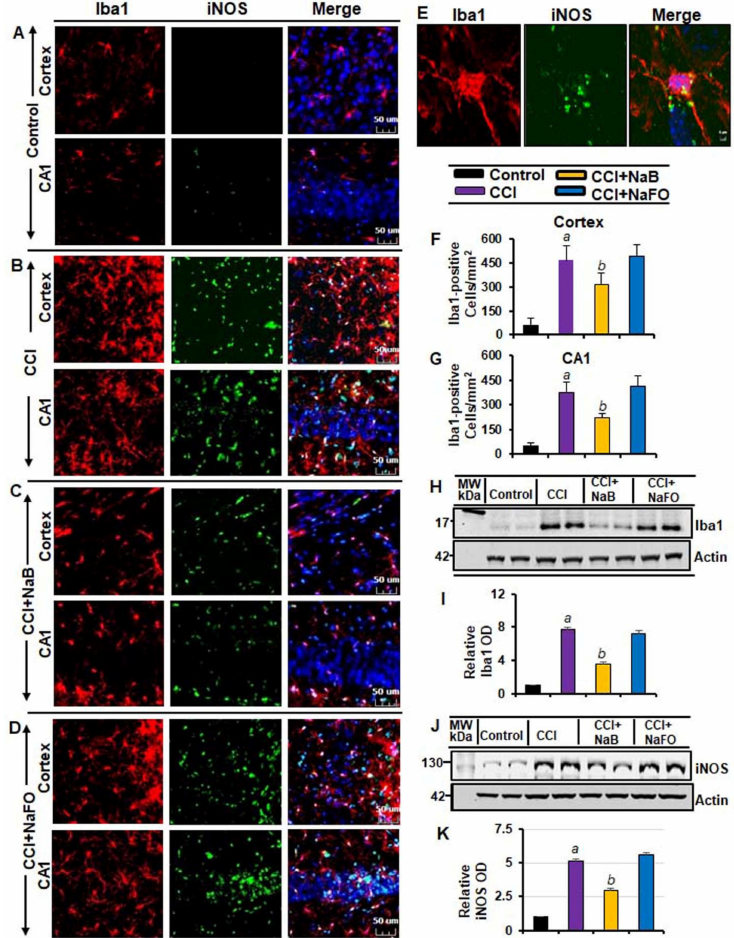
Figure 3. NaB treatment inhibits microglial activation in vivo in the cortex and hippocampus of mice with CCI injury. Mice were treated with 50 mg/kg/day of NaB or NaFO from 24 h after the induction of CCI injury. After 7 d of treatment, brain sections were analyzed by double-label fluorescence for Iba1 and iNOS (( A ), control; ( B ), CCI; ( C ), CCI+NaB; ( D ), CCI+NaFO). ( E ) Confocal image demonstrating the co-localization of iNOS and Iba1 in the cortex. Cells positive for Iba1 were counted in the cortex ( F ) and CA1 region ( G ). Results represent analysis of six sections of six mice each per group: a p < 0.001 vs. control; b p < 0.001 vs. CCI. Hippocampal tissue extracts from all groups of mice ( n = 4 per group) were immunoblotted for Iba1 ( H ) and iNOS ( J ). Actin was run as a loading control. Bands were scanned, and values (( I ), Iba1/Actin; ( K ), iNOS/Actin) are presented as relative to control. a p < 0.001 vs. control; b p < 0.001 vs.